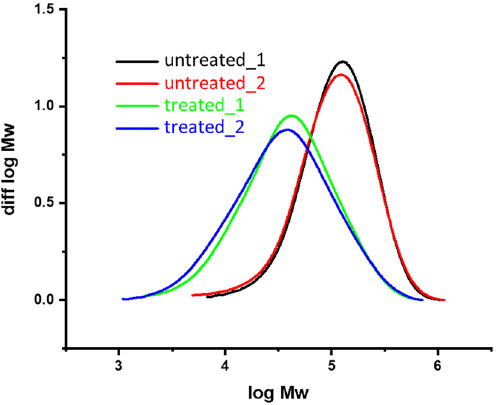
Figure 11. molar mass distribution of 2440 dtex yarns without treatment (black and red line) and with pMDI- hardener treatment followed by purification with NMP (green and blue